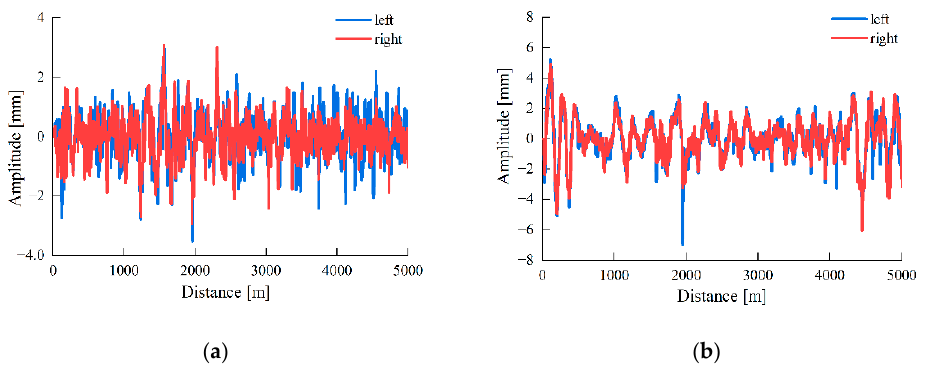
Figure 9. Track irregularity: ( a ) Lateral, ( b ) Vertical.